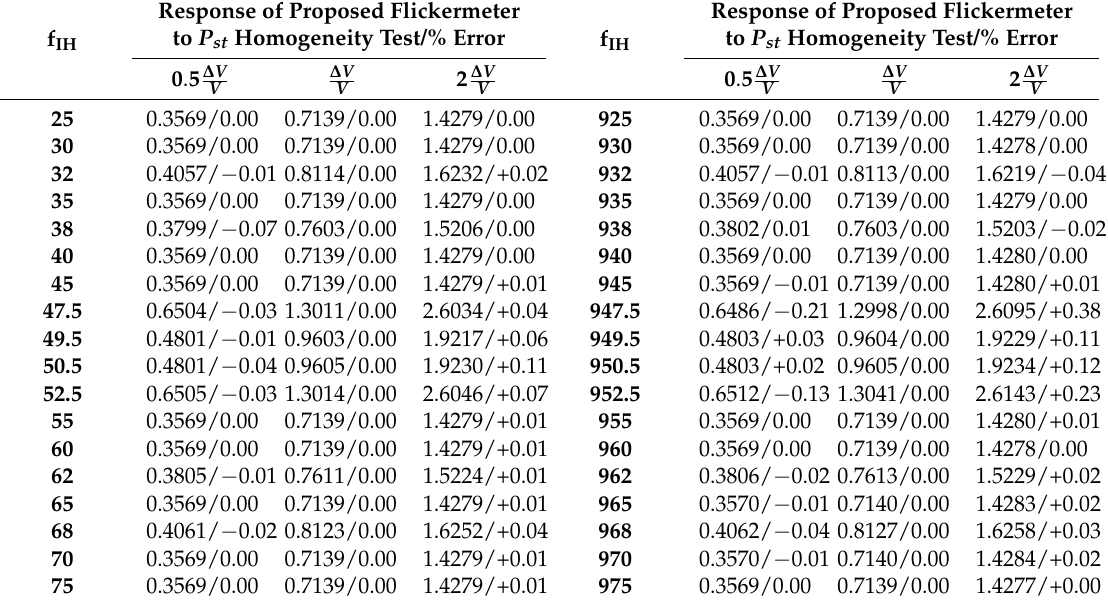
Table 5. Response of proposed flickermeter to P st homogeneity